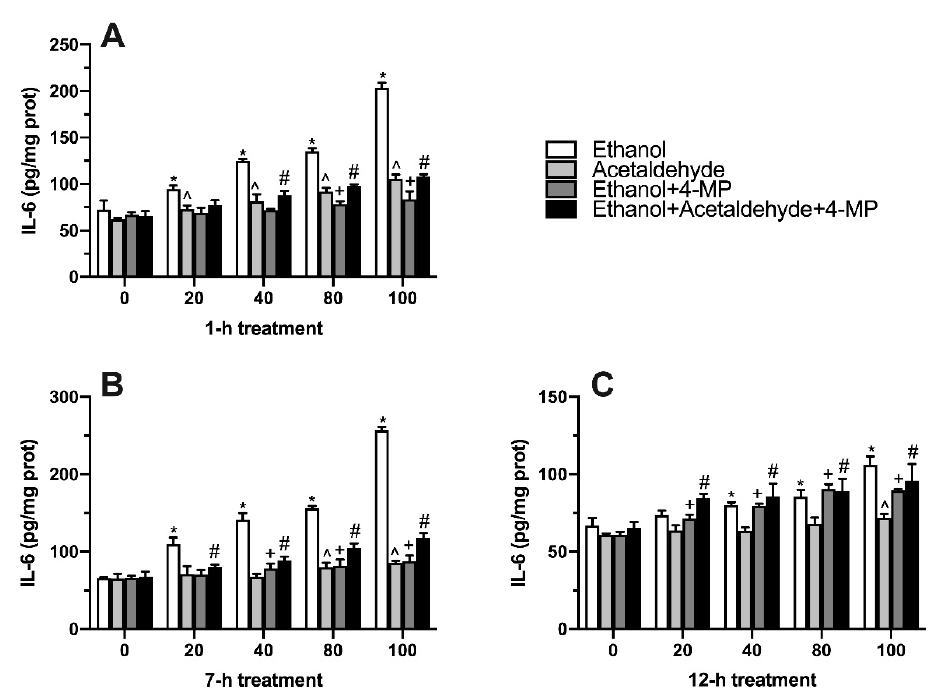
Figure 6. Effect of four different treatments on IL-6 content in L02 cell lines treated for 1 h ( A ), 7 h ( B ), and 12 h ( C ). Values represent means ± SD (n ≥ 6). * p < 0.05 compared with 0 mM ethanol, ^ p < 0.05 compared with 0 µM acetaldehyde, + p < 0.05 compared with 0 mM ethanol + 500 µM 4-MP, # p < 0.05 compared with 0 mM ethanol + 0 µM acetaldehyde + 500 µM 4-MP.